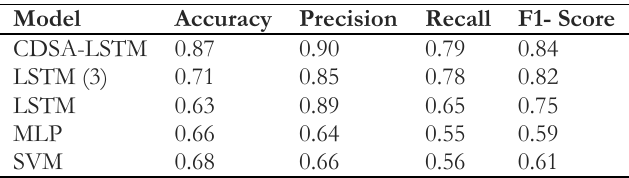
Table 3. Performance of models.